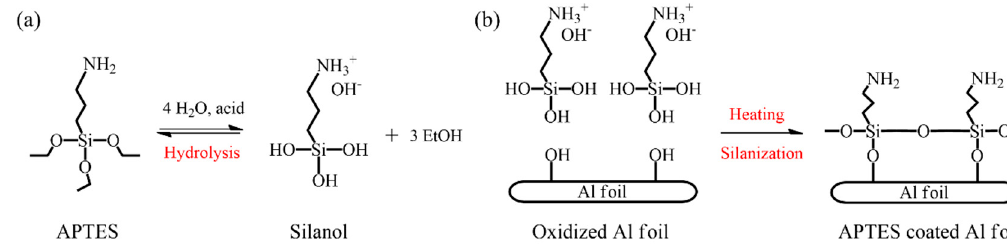
Figure 6. Mechanism for the surface treatment of Al foil with APTES: ( a ) hydrolysis of APTES in acidic condition; ( b ) silanization between oxidized Al foil and silanol.